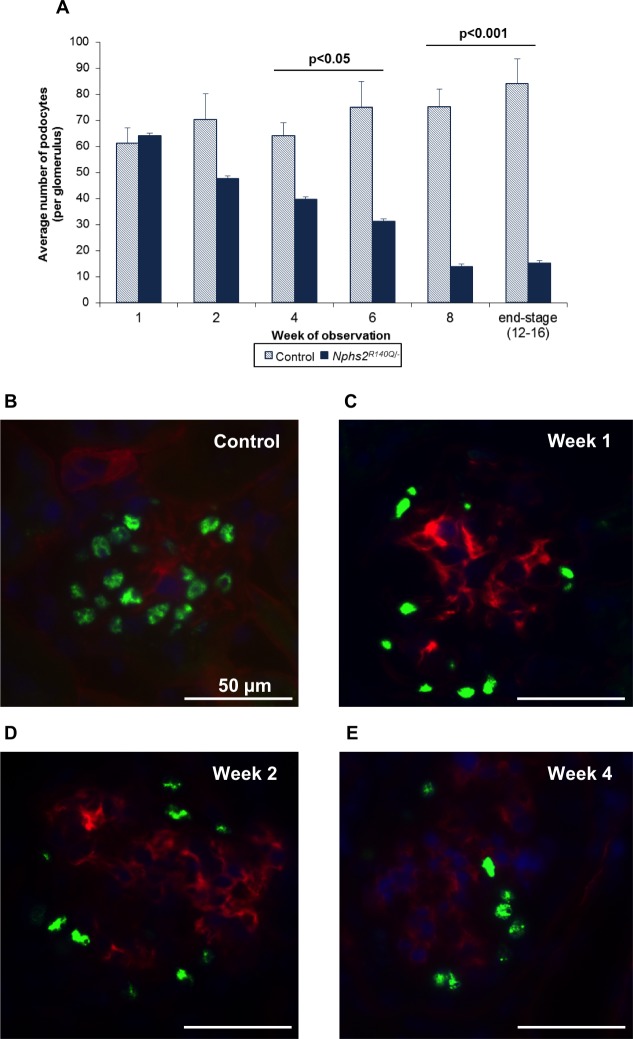
Podocyte loss in Nphs2R140Q/- mice.(A) Number of podocytes reduced in induced mice with the course of the disease (columns represent 4–6 animals per group and time point). (B) Wt1 labelled podocytes in glomerulus in a healthy animal. Decreased Wt1 signal in Nphs2R140Q/- animals 1 week (C), 2 weeks (D), and 4 weeks after induction (E). Wt1: green, nidogen: red, nucleus: blue. Magnification, X640.